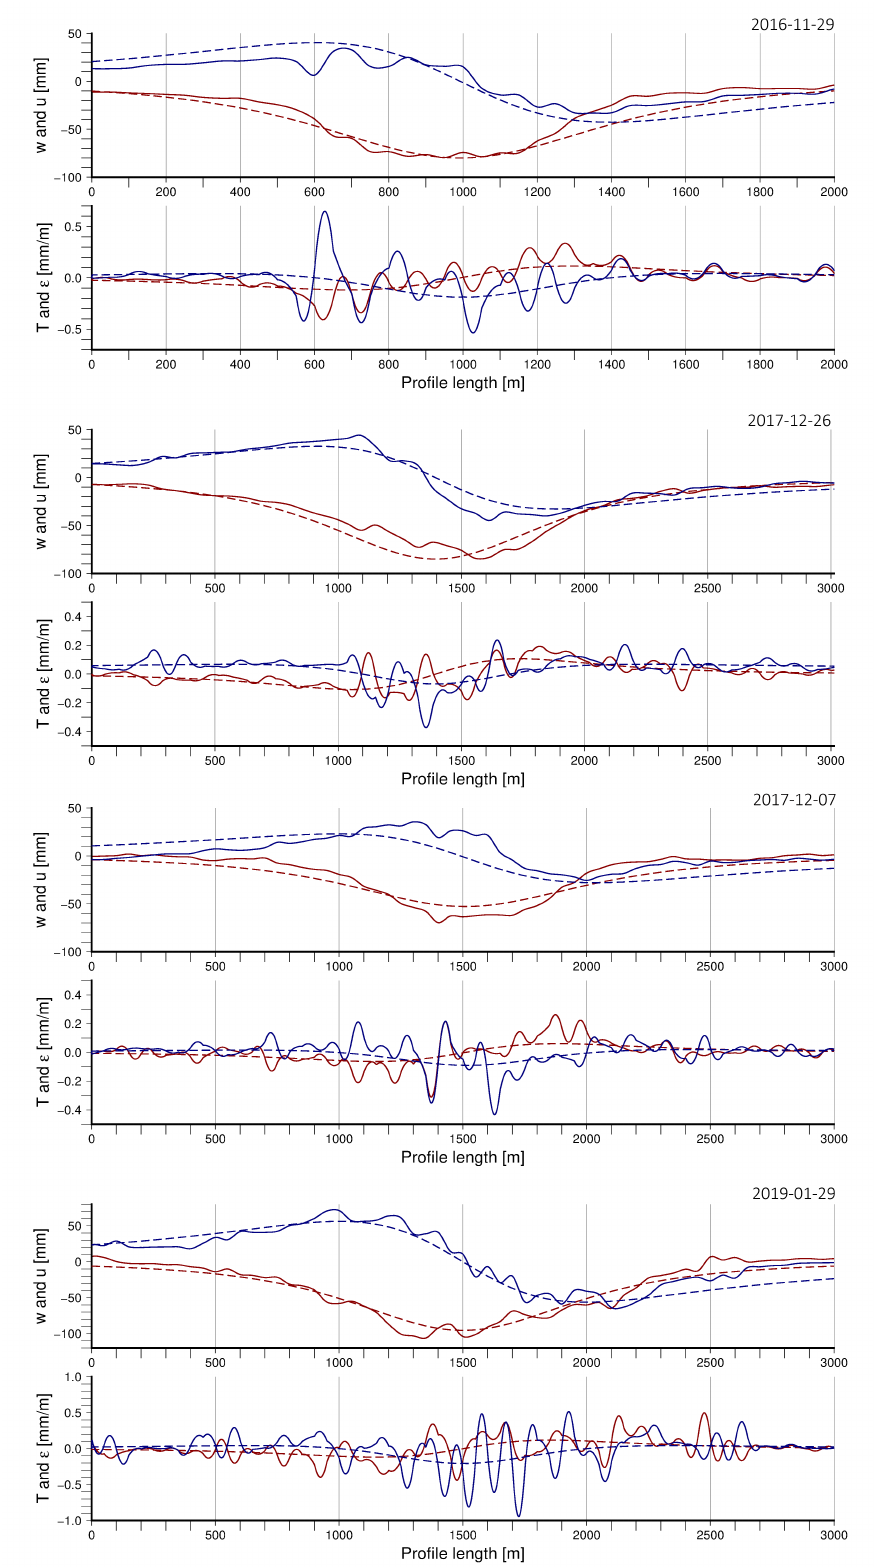
Figure 11. Profiles (E-W cross-section) of the deformation indicators for modeled (dashed lines) and observed (solid lines) displacements caused by the analyzed mining tremors. For each analyzed tremor the upper profile represents subsidence (red) and horizontal shift (blue), while the lower profile shows slope (red) and strain